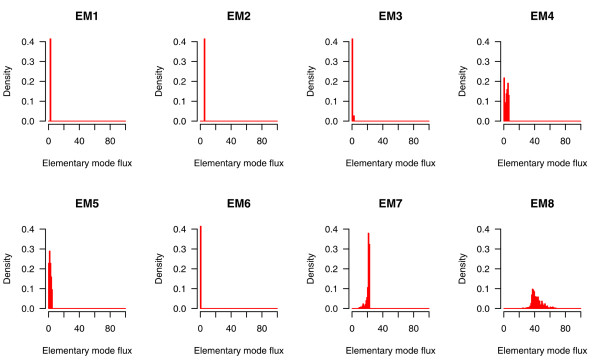
Elementary mode fluxes spanned by external concentrations. Distributions of elementary mode fluxes obtained for 400 random sets of glucose and ethanol concentration values. Glucose concentration was allowed to vary between 2 and 100, ethanol concentration between 1 and 600. Vertical axes have been cut at 0.4 but the height of peaks for constant modes extends till 1.